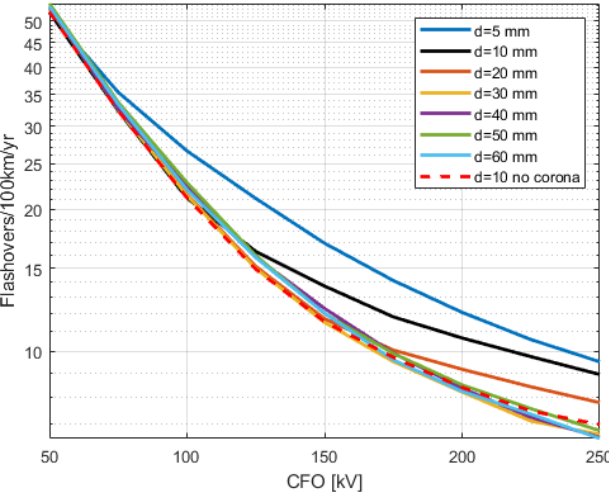
Figure 5. Comparison of the lightning performance of an overhead distribution line with different diameters—the red dot line represents the case when the corona effect is not